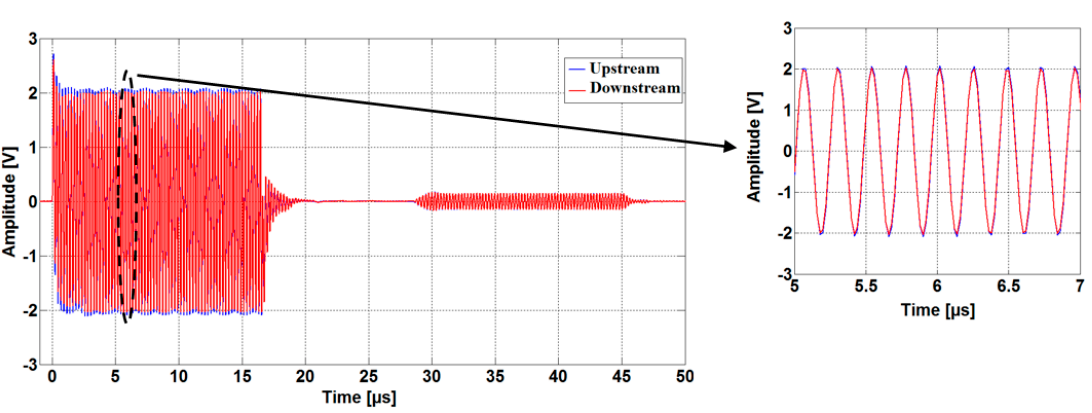
Figure 11. Acquired ultrasonic signals in the upstream and downstream directions (measured using a driving frequency of 4.19 MHz).